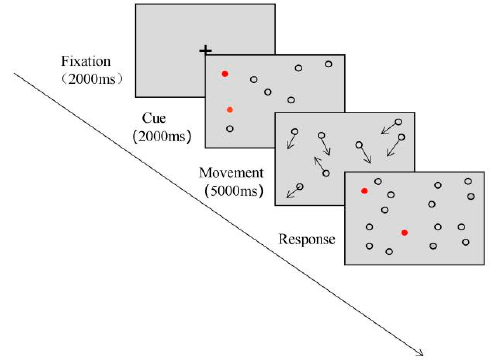
Figure 1. Classical MOT task (target number is four). Figure 1. Classic al MOT task (target number is four). Figure 1. Classic al MOT task (target number is four).